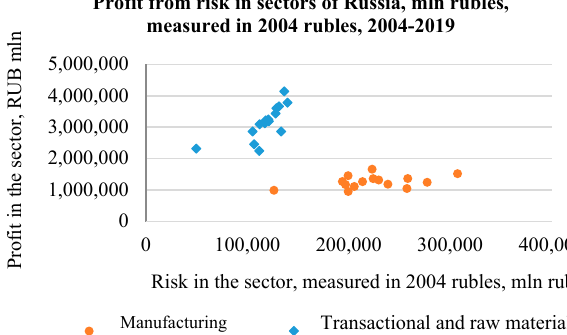
Figure 9. Profitability and risk (above) profit and risk (below) in the sectors in the Russian economy, 2004–2019 (measured in 2004 rubles, million rubles) 7 .